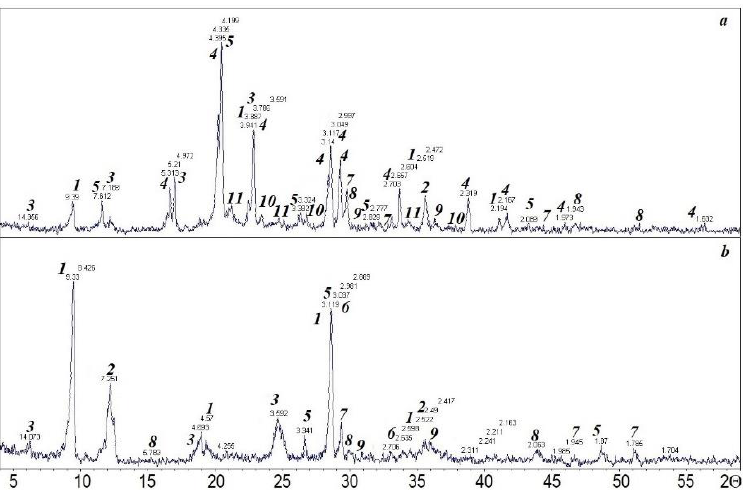
Figure 2. XRD pattern of the clinker after roasting at 300 °C ( a ) and of the leaching residue ( b ). Numbers indicate reflexes: 1—talc; 2—lizardite; 3—clinochlore; 4—mascagnite; 5—pyracmonite; 6—chalcopyrite; 7—pyrrhotite; 8—pentlandite; 9—magnetite; 10—nickel sulfate; 11—chalcocyanite.